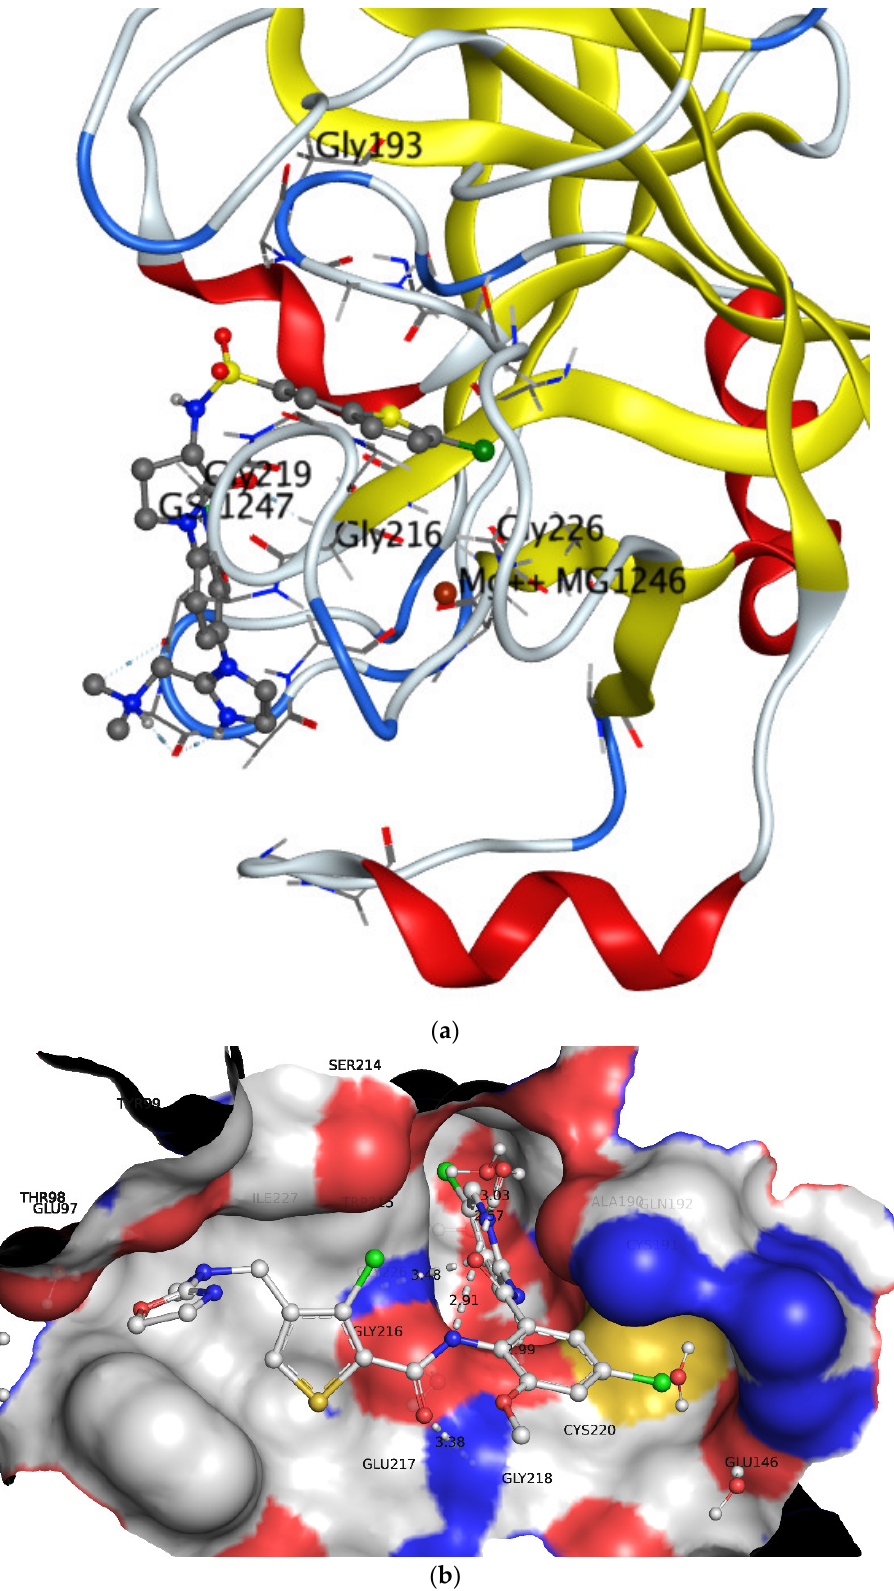
Figure 6. X-ray resolved pose for 1 in the active site of factor Xa (pdb 1MQ6) ( a ) without surface ( b ) with surface.